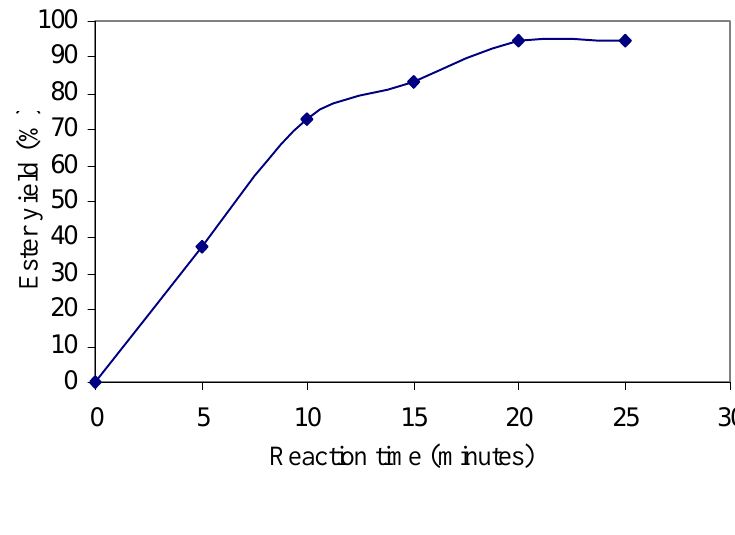
Figure 1. Trend of ester conversion with time.